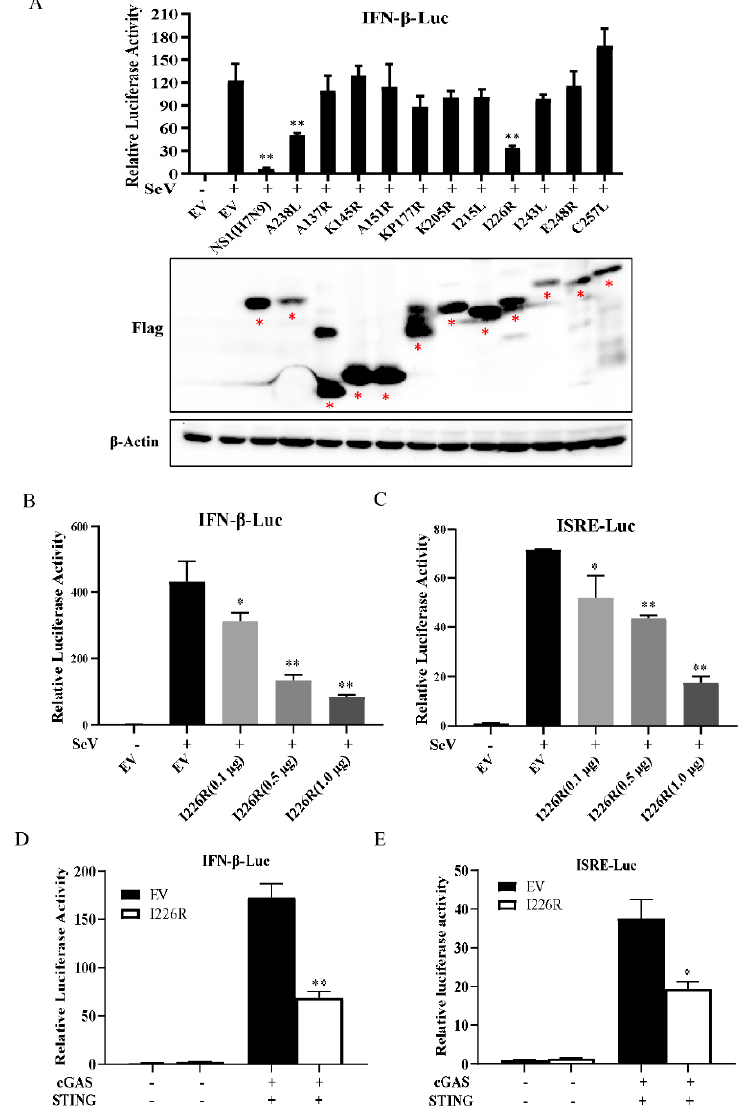
Figure 1. The I226R protein is a key inhibitor of IFN- β response: ( A ) 293T cells were co-transfected with 500 ng IFN- β -Luc, 50 ng pRL-TK, and 500 ng empty vector (EV) or other expression plasmids encoding the indicated ASFV viral proteins. After 24 h of co-transfection, cells were infected with SeV. Then, dual-luciferase activity was examined at 16 hpi. Western blotting was performed to examine the expression of candidate ASFV proteins. ( B , C ) 293T cells were co-transfected with 500 ng IFN- β -Luc ( B ) or ISRE-Luc ( C ), 50 ng pRL-TK, and I226R-Flag plasmid (0.1, 0.5, or 1.0 µ g) or EV for 24 h, and infected with SeV for 16 h. Dual-luciferase activity assay was performed. ( D , E ) 293T cells were co-transfected with 300 ng IFN- β -Luc ( D ) or ISRE-Luc ( E ), along with 30 ng pRL-TK, 300 ng cGAS-Flag and 50 ng STING-HA, and 300 ng I226R-Flag or EV and for 24 h; then, dual-luciferase activity assay was performed. All the results are expressed as the means ± standard deviation from three independent experiments. Statistical analysis was performed using the Student’s t -test. * p < 0.05; ** p < 0.01.